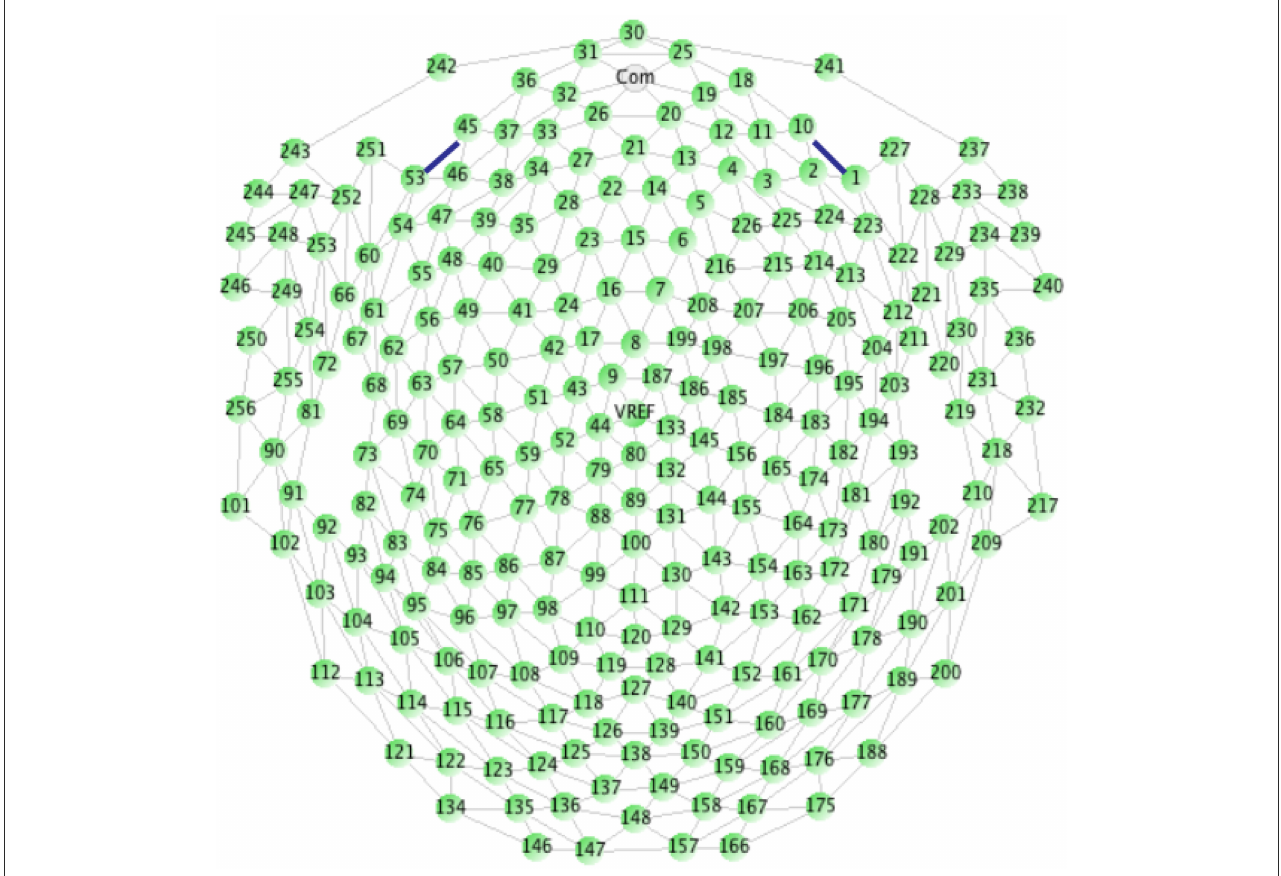
FIGURE1 Electrodes placement on HydroCel GSN 130 Geodesic Sensor Net (Geodesics,